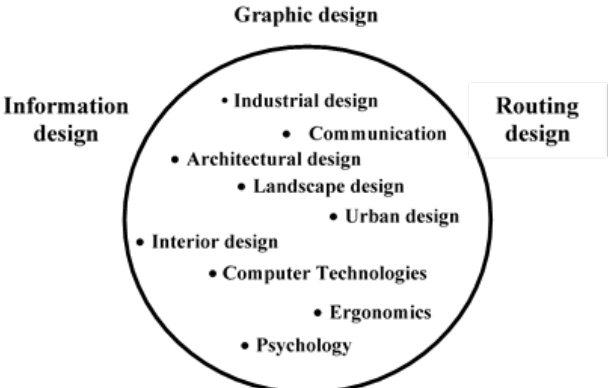
Figure 1. Interdisciplinary cooperation in information and direction